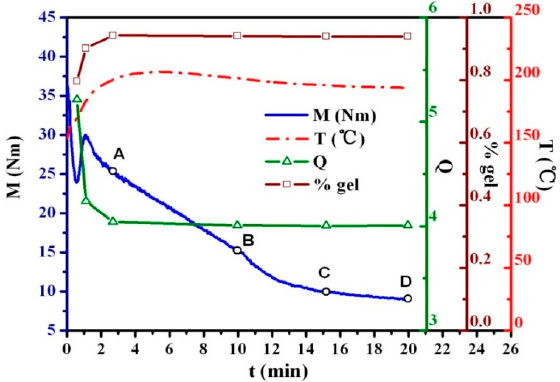
Figure 1. Variations of torque ( M ), temperature ( T ), swell ratio ( Q ) and rubber gel content (% gel)